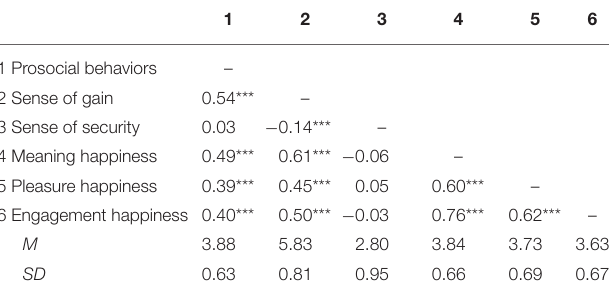
TABLE 2 | Correlations among the key study variables ( N =